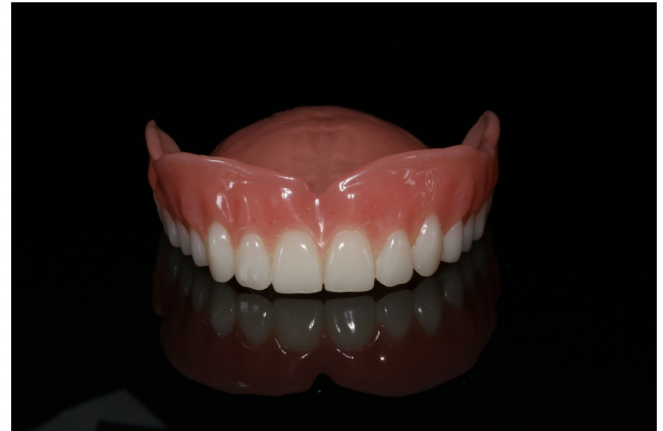
Figure 18. Polished complete denture in the upper jaw ready for